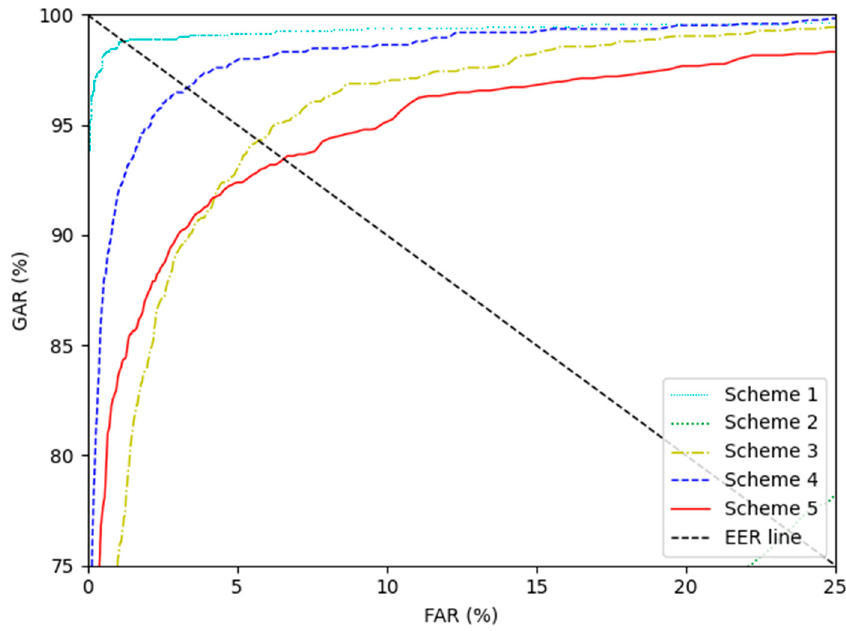
Figure 29. ROC curves of finger-vein recognition for schemes 1–5 with PolyU-DB (random motion blur and optical blur with intensity 19 × 19 (Gaussian filter size) and 19 (Gaussian filter standard deviation)).